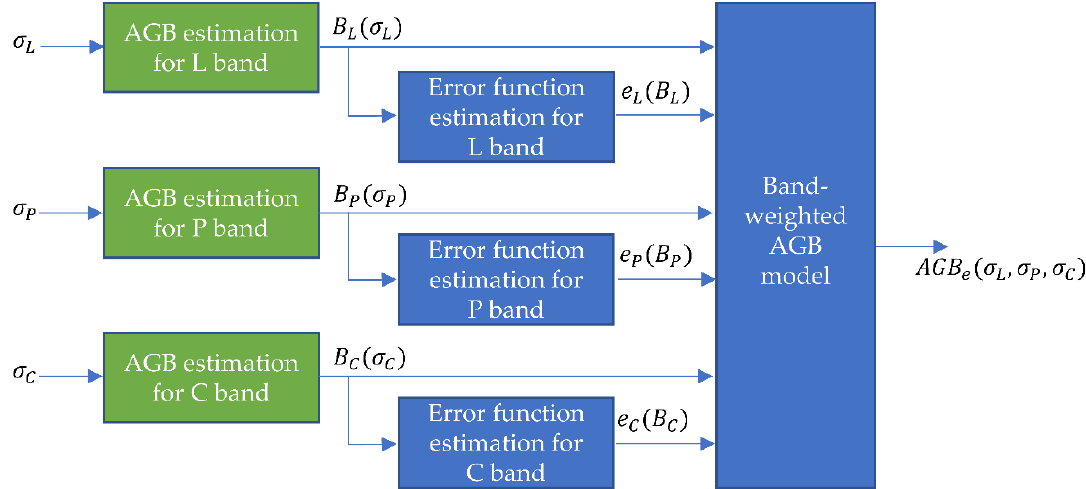
Figure 4. Block diagram for the AGB estimation.